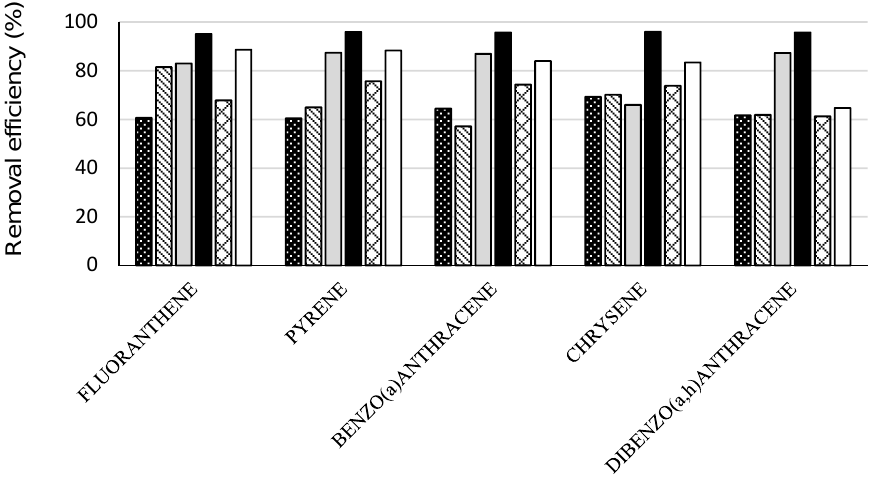
Figure 4. Removal efficiency of 4- and 5- ring PAH from surface water.